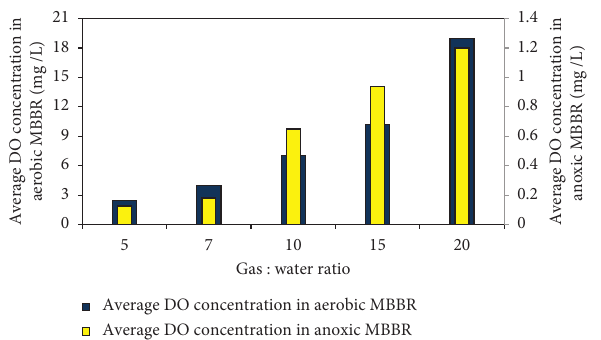
Figure 5: Performance of A/O MBBRs system for TN removal under different gas :water ratios.